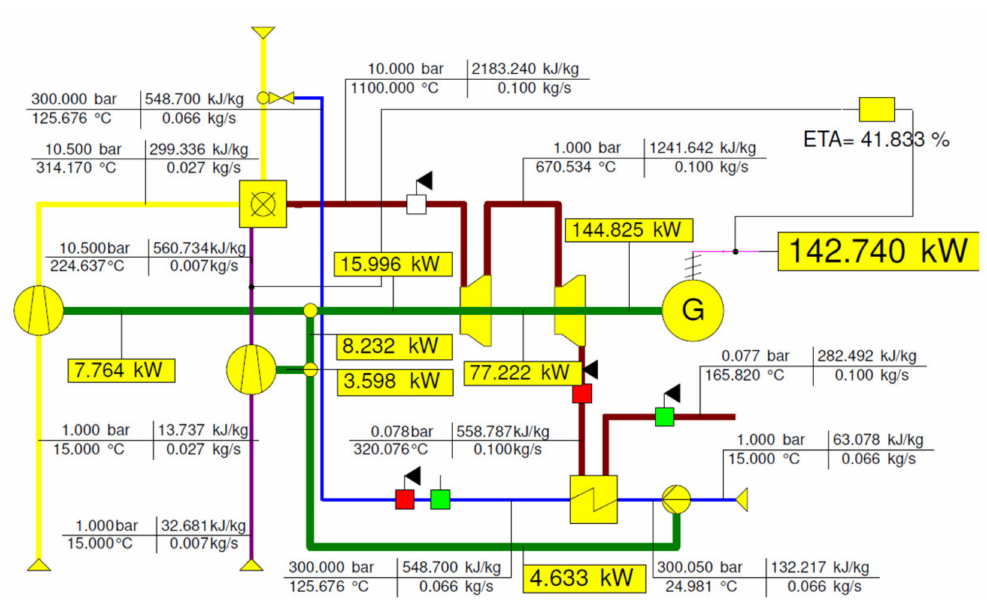
Figure 4. Simulation of PFD0 by Ebsilon (0FUEL, 0O 2 , 01-H 2 O, 02-H 2 O, 1FUEL, 1O 2 , 1H 2 O, 2, 3, 4, 5— cycle nodal